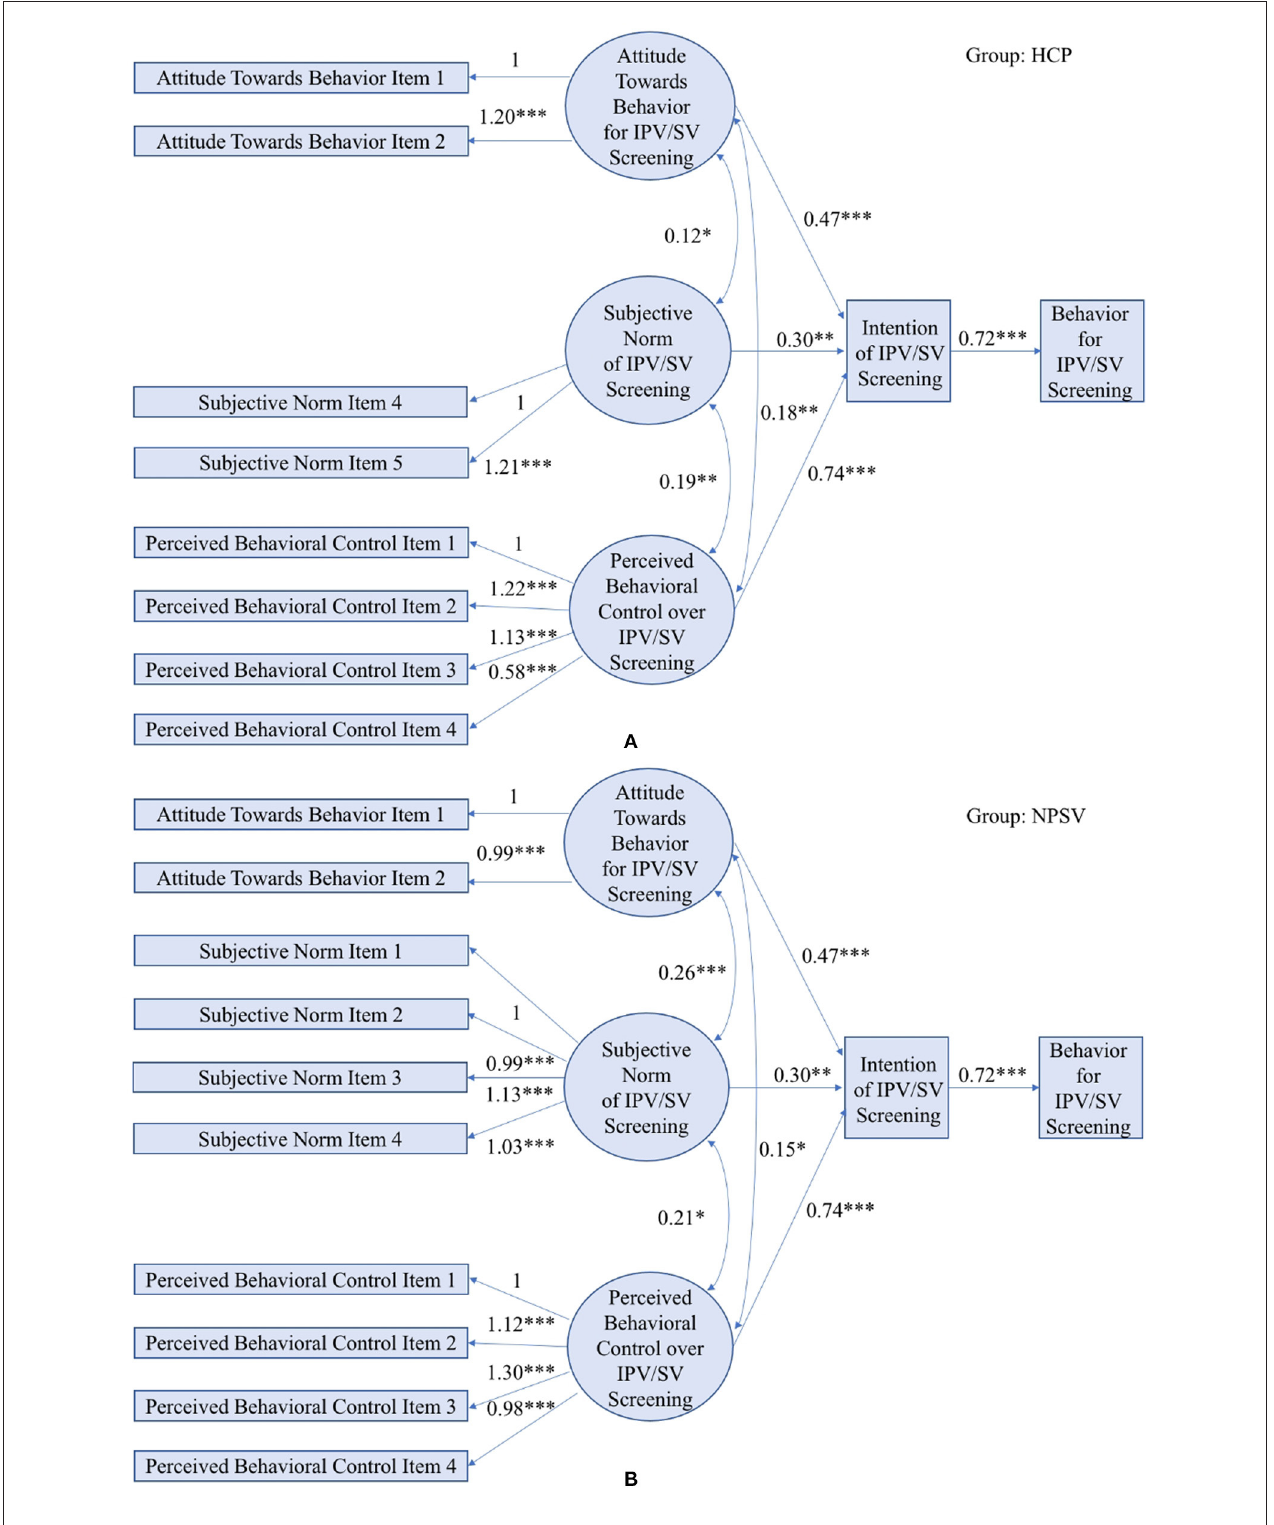
FIGURE 3 | A constrained multi-group SEM applied to TPB in the HCP study (A) and the NPVS study (B) . (Model fit indices: LRT p -value < 0.001, CFI = 0.96, TLI = 0.94, RMSEA = 0.075; *** indicates p -value < 0.001, ** indicates p -value < 0.01, * indicates p -value < 0.05).